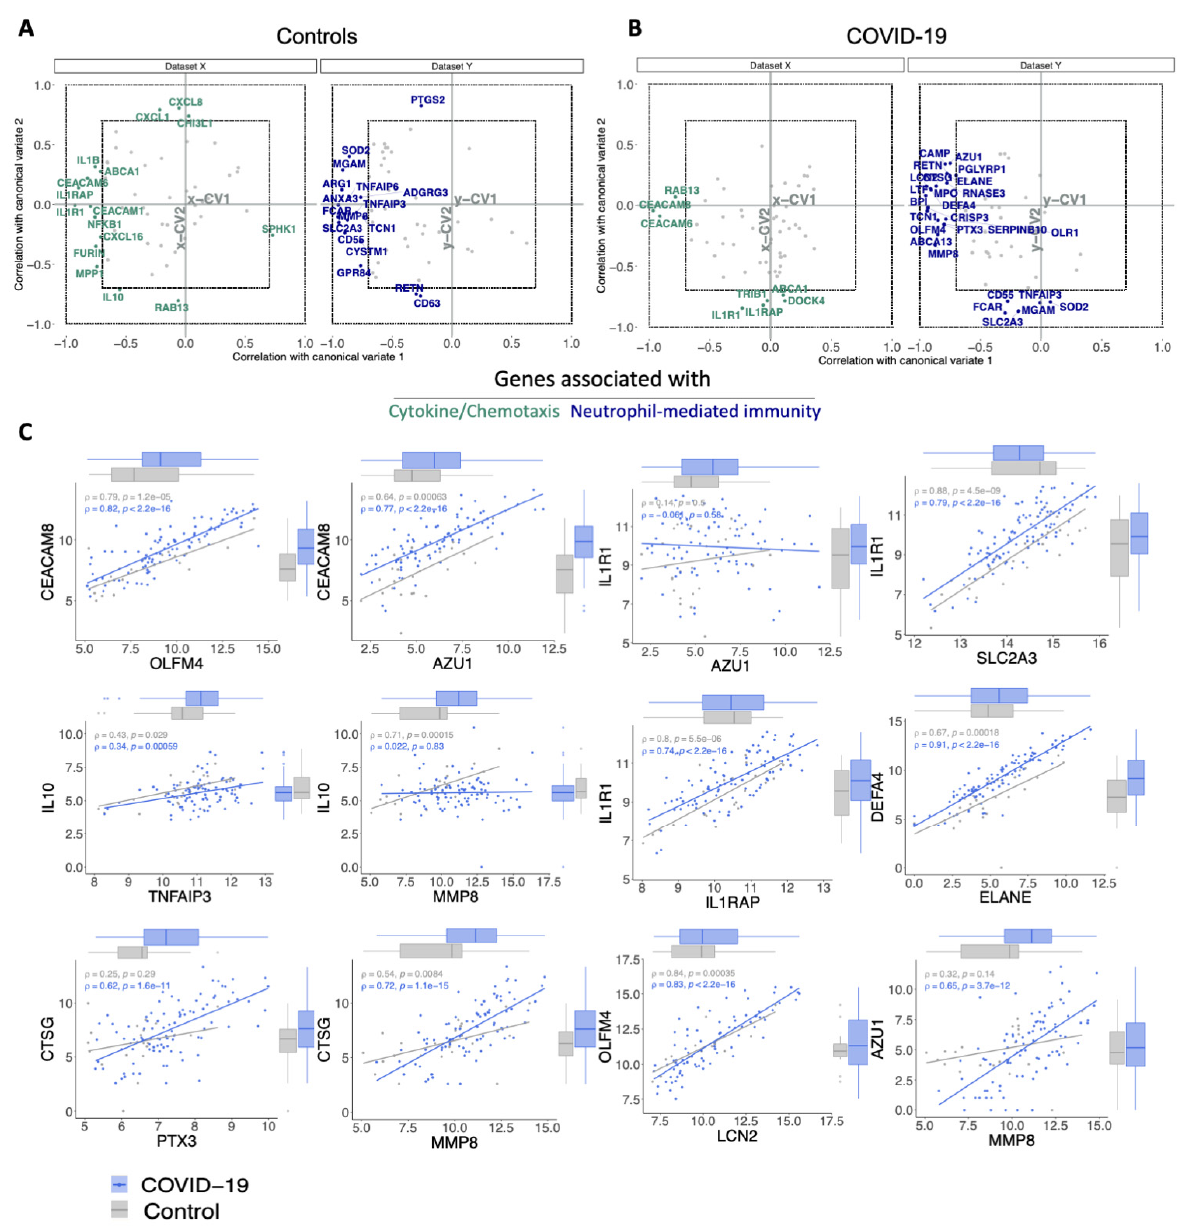
Figure 3. Infection with SARS-CoV-2 impacts the correlation between cytokine/chemotaxis- and neutrophil-mediated immunity genes. ( A,B ) Estimated correlations of cytokine signaling/chemotaxis and neutrophil-mediated immunity molecules ranging from − 1 to 1 versus their corresponding first two canonical variates (x-CV1 and x-CV2 for cytokine/chemotaxis-related genes; y-CV1 and y-CV2 for neutrophil-mediated immunity genes) in ( A ) controls and ( B ) COVID-19 patients. Cytokine/chemotaxis and neutrophil-mediated immunity genes with a Spearman rank correlation of ≥ 0.7 are colored in green and blue, respectively, while those with a Spearman rank correlation of <0.7 are gray in both groups. ( C ) Scatter plots with marginal boxplots display the relationship between variables (genes). Correlation coefficient ( ρ ) and significance level ( p -value) for each correlation are shown within each graph.